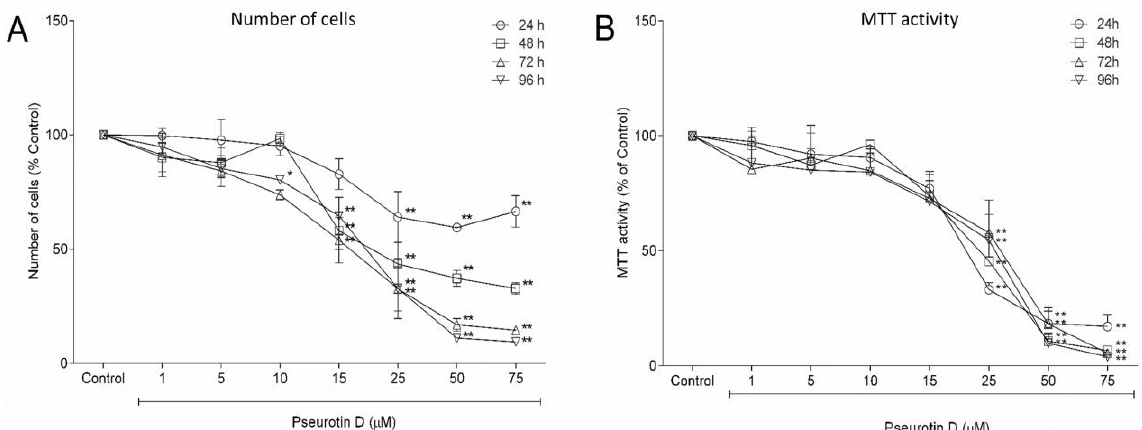
Figure 1. The effect of pseurotin D (1–75 µ M) on MEC-1 proliferation and viability determined according to the number of cells ( A ) and MTT activity ( B ) after 24, 48, 72, and 96 h of incubation. Data are expressed as a percentage of the untreated control (mean ± SEM, n = 4). One sample t -test was used to analyze the significance of the obtained data separately comparing the effect of each compound with untreated control. Bonferroni correction of the p -value for multiple comparisons was performed (** p < 0.01 and * p < 0.05).